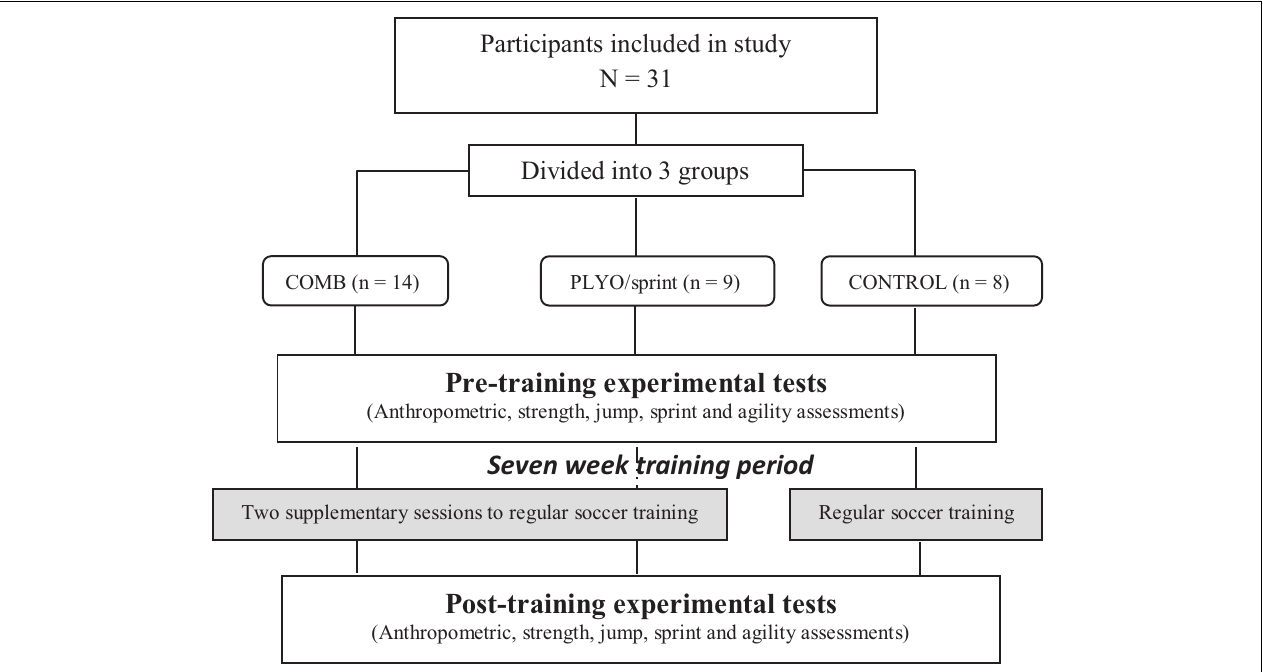
FIGURE 1 | Experimental design. COMB: combination of 1 plyometric/sprint and 1 traditional resistance training sessions per week. Plyo/sprint: addition of 2 plyometric and sprint training sessions per week.